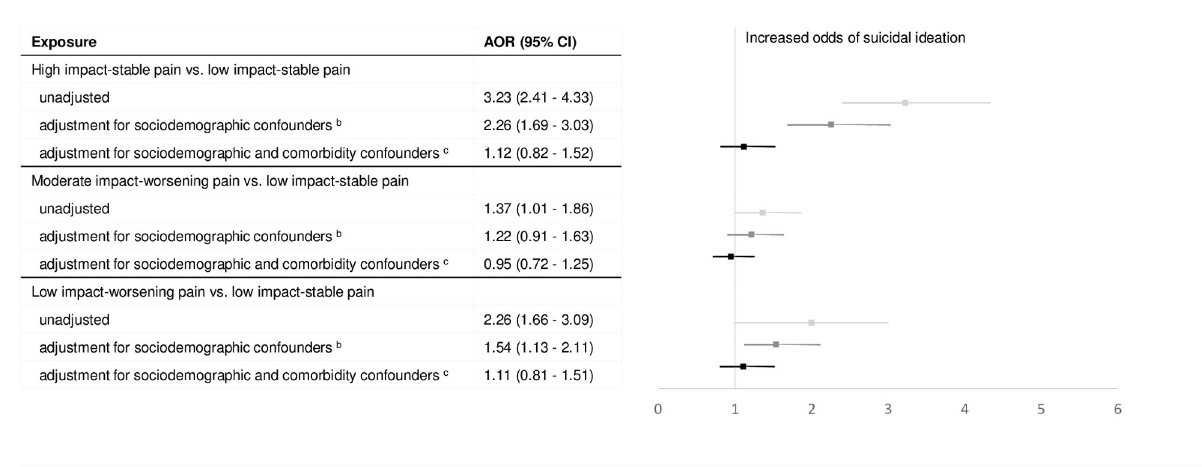
Fig 2. Effects of pain phenotypes on suicidal ideation. a Forest plot with odds ratio and 95% confidence intervals of the pain phenotypes with low impact-stable pain as reference from the multinomial logistic regression models. The figure shows the effect sizes with and without weights and using the long and short set of covariates for suicidal ideation. b The short set covariates includes sociodemographic characteristics (excludes comorbid health conditions) as predictors. c The long set covariates includes all covariates–sociodemographic characteristics and comorbidities.